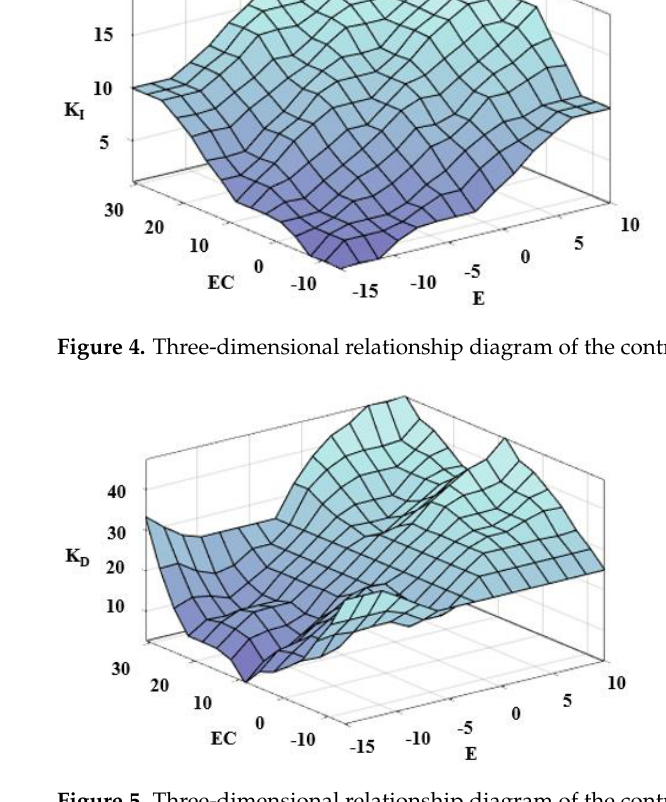
Figure 5. Three-dimensional relationship diagram of the control parameter K D ⚫ Defuzzification.